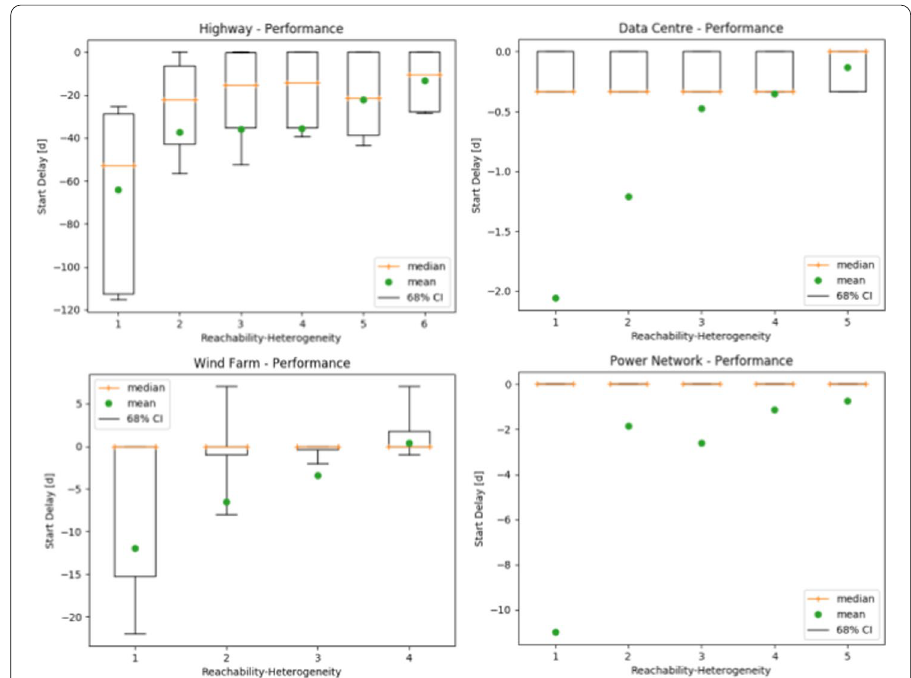
Fig. 4 For each activity of each project, we report Start Delay (in days) and RH score (at the node level). Data are binned uniformly along the RH dimension to mitigate noise. A trend emerges in all four datasets with higher RH values corresponding to longer delays, i.e., worse performance. As it is particularly evident from DC and PN, a significant contribution to this phenomenon comes for the outliers in the Start Delay distribution, the best-performing activities, that tend to score low in RH. Bin cuts and bin populations for all datasets are reported in Table